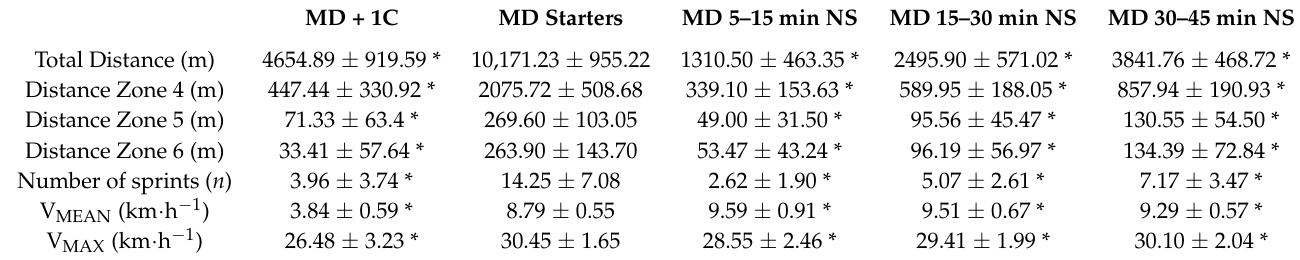
Table 2. Absolute distances covered and high-intensity actions during compensatory training